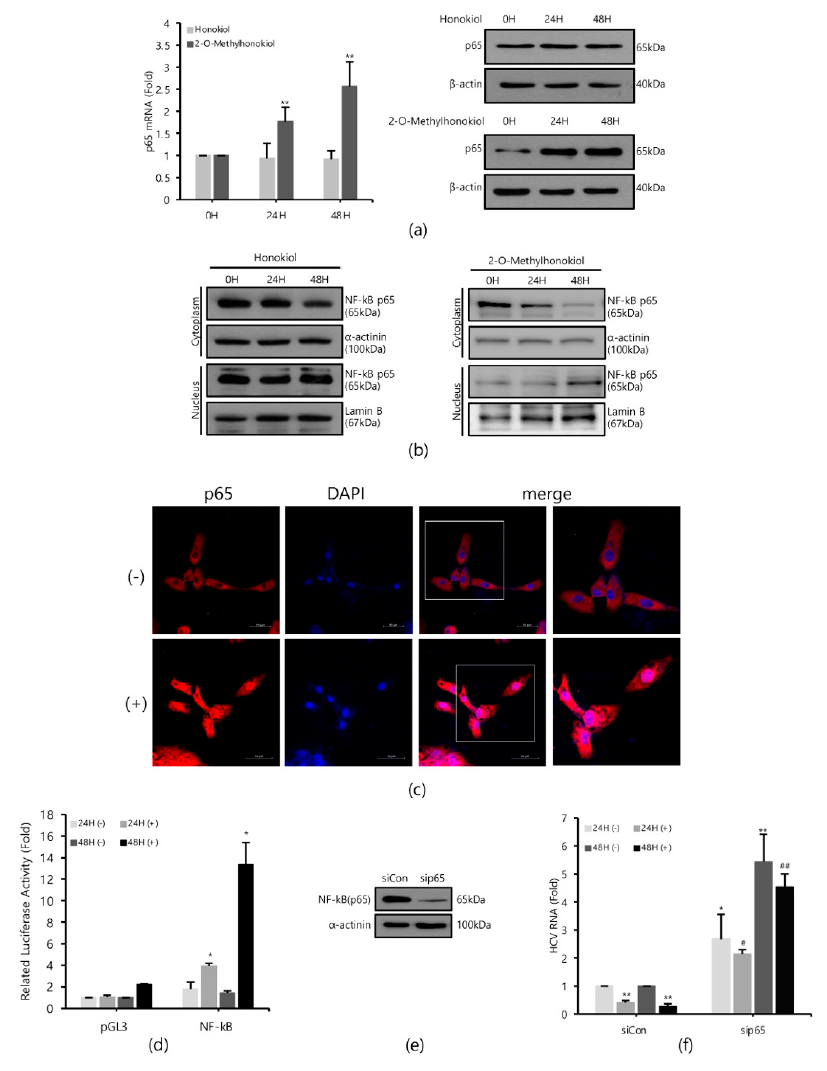
Figure 3. 2-O-methylhonokiol inhibits HCV replication via NF-kB activation, but honokiol does not. ( a ) After treatment of 50 µ M of 2-O-methylhonokiol and honokiol for 24 or 48 h, p65 mRNA levels were measured by qRT-PCR (left), and Western blotting analysis of p65 protein (right), using Huh7.5/Con1 cells. ( b ) Cytosol or nuclear fractions were isolated and analyzed by Western blotting in huh7.5/Con1 cells treated with 50 µ M 2-O-methylhonokiol (right), and honokiol (left), for 24 or 48 h. Lamin B (nuclear marker) and α -actinin (cytosolic marker) immunoblotting were also included to confirm the purity of the nuclear and cytosolic fractions, respectively. ( c ) Huh7.5/Con1 cells were treated with or without 50 µ M 2-O-methylhonokiol for 24 h, and then subjected to immunofluorescence with anti-p65 antibody (red). DAPI (blue) was used for nuclear staining. Scale bar = 50 µ m. ( d ) Huh7.5/Con1 cells were transfected with pGL3-Luc-NF-kB plasmid or the empty pGL3 vector for 24 h. Luciferase activity was measured after treatment with or without 50 µ M 2-O-methylHonokiol for 24 or 48 h. Luciferase activity was expressed relative to that in DMSO-treated cells. ( e ) Expression of NF-kB(p65) protein in control (si-Con) and NF-kB(p65)-interfered (si-RelA/p65) Huh7.5/Con1 cells was shown. ( f ) After transfection with si-Con or si-RelA/p65 for 48 h, Huh7.5/Con1 cells were treated with or without 50 µ M 2-O-methylhonokiol for 24 or 48 h. The HCV RNA level were then analyzed by qRT-PCR. The values are shown as the mean ± SD of five independent experiments. * p < 0.05, ** p < 0.01 versus untreated control or versus the untreated siCon-transfected control; # p < 0.05, ## p < 0.01 versus the 2-O-methylhonokiol-treated, siCon-transfected control; one-way ANOVA with Tukey’s multiple comparisons